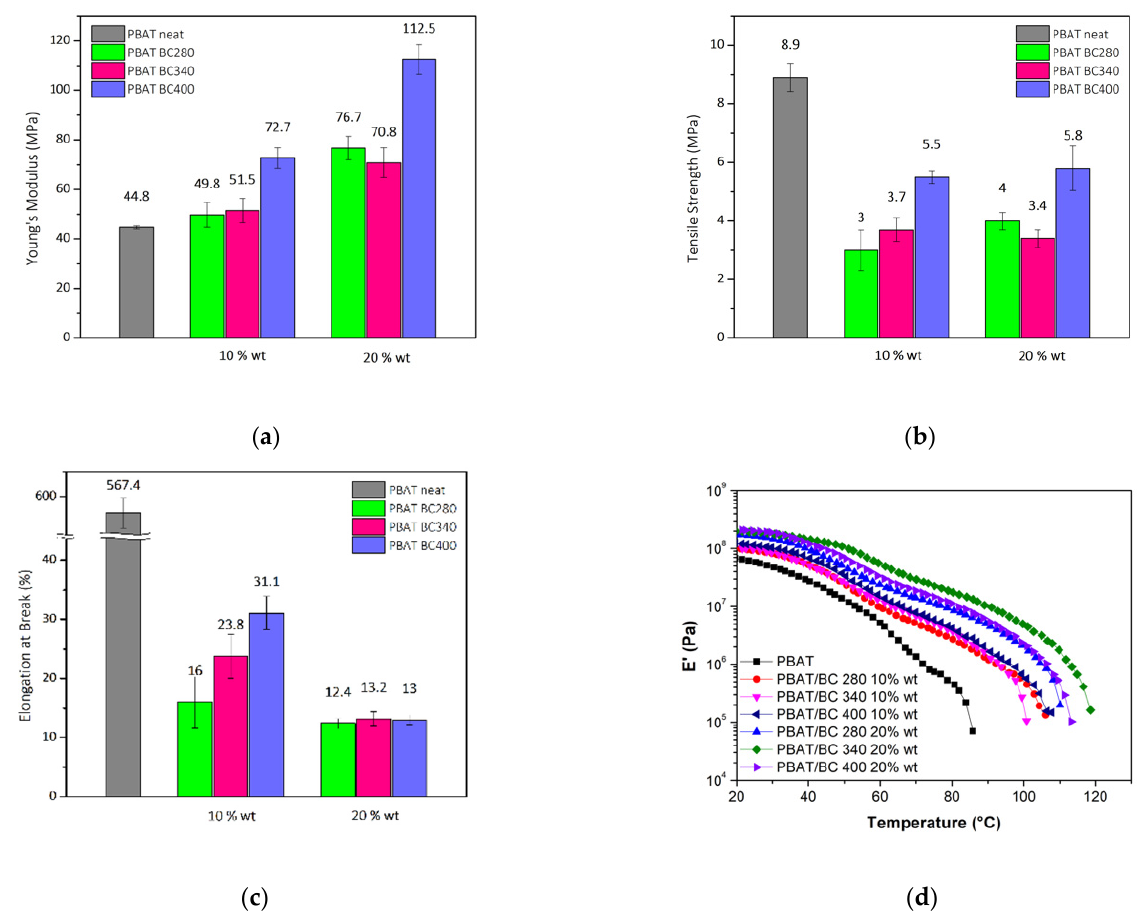
Figure 7. Main mechanical properties, i.e., ( a ) Young’s Modulus, E, ( b ) tensile strength, TS, and ( c ) elongation at break, EB, and ( d ) storge modulus, E’, vs. temperature of PBAT/BCP biocomposites.